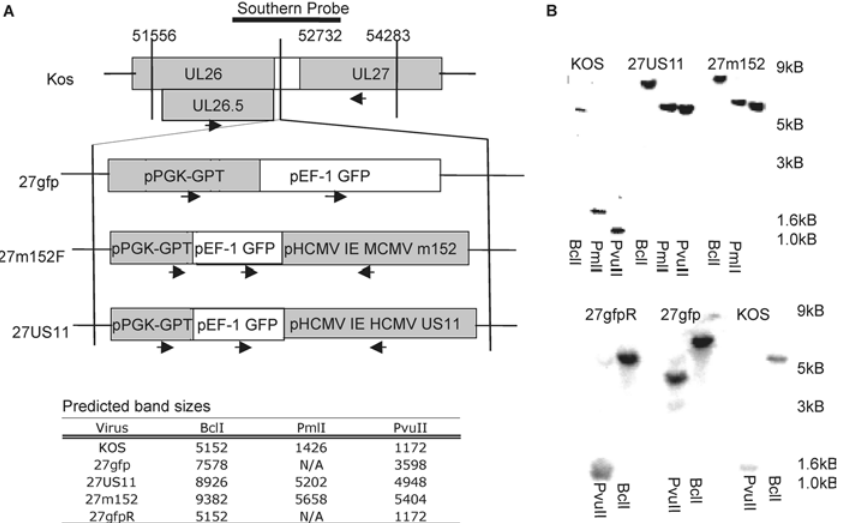
Figure 1. Generation of rHSVs (A) rHSVs expressing MCMV m152 (27m152), HCMV US11 (27US11), or only the selection cassette (27gfp) were generated via homologous recombination with KOS strain HSV-1. Contents and location of insertions are indicated. Arrows indicate direction of transcription. The probe used to isolate correctly recombined viruses is indicated. (B) Genomic DNA from KOS, 27US11, 27m152, 27gfp, and 27gfpR was digested with the indicated restriction enzymes and probed for the junction of HSV UL26–UL27. The predicted band sizes are indicated in the tabular inset. DOI: 10.1371/journal.ppat.0010007.g001